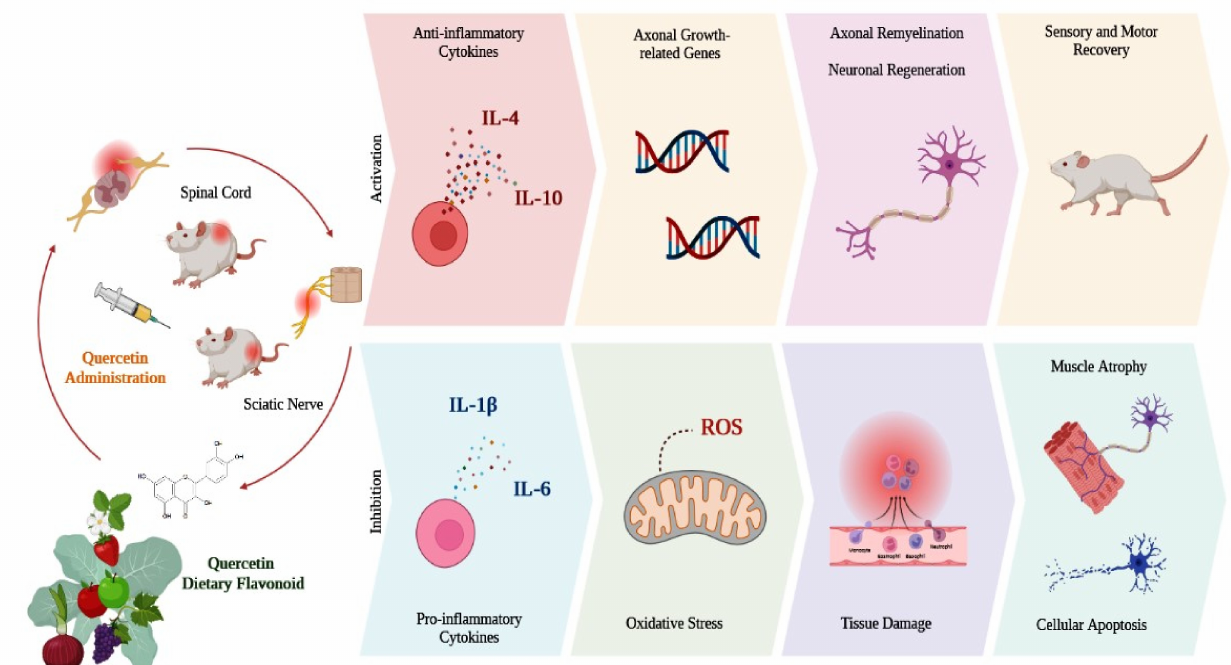
Figure 3. Schematic illustration of the main outcomes of the studies included in this literature review. In SCI and sciatic nerve injury models, quercetin administration inhibited the synthesis of pro-inflammatory cytokines, oxidative stress, and cell apoptosis, thus minimizing tissue damage and muscle atrophy. Similarly, quercetin favored the synthesis of anti-inflammatory cytokines and the expression of growth-related genes, promoting axonal remyelination and neuronal regeneration, accelerating sensory and motor recovery, and improving locomotor capacity. Interleukin-4 (IL-4); Interleukin-10 (IL-10); Interleukin-1 beta (IL-1 β ); Interleukin-6 (IL-6); Reactive Oxygen Species